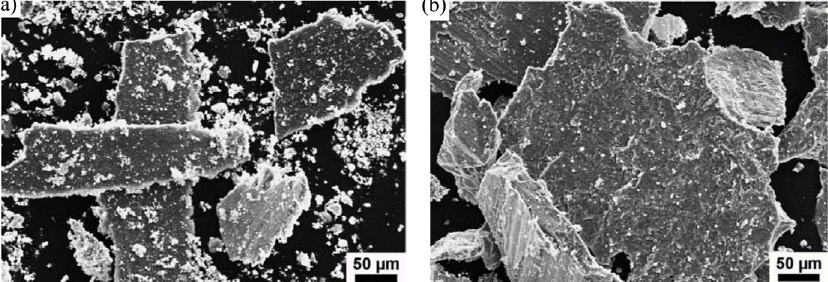
Fig. 7 Wear debris emanated from ThO-Ti64 alloy specimen at distinct sliding conditions (coupling load = 50 N, sliding distance = 3,000 m): (a) sliding speed = 0.4 m·s − 1 ; (b) sliding speed = 1.6 m·s − 1 . Reproduced with permission from Ref. [26]. Copyright Elsevier,